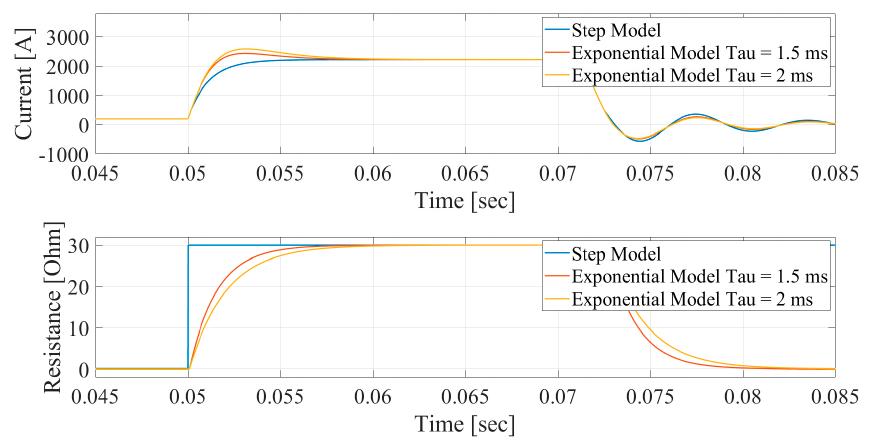
Figure 7. Step Model and Exponential Model analysis for different transition time values.